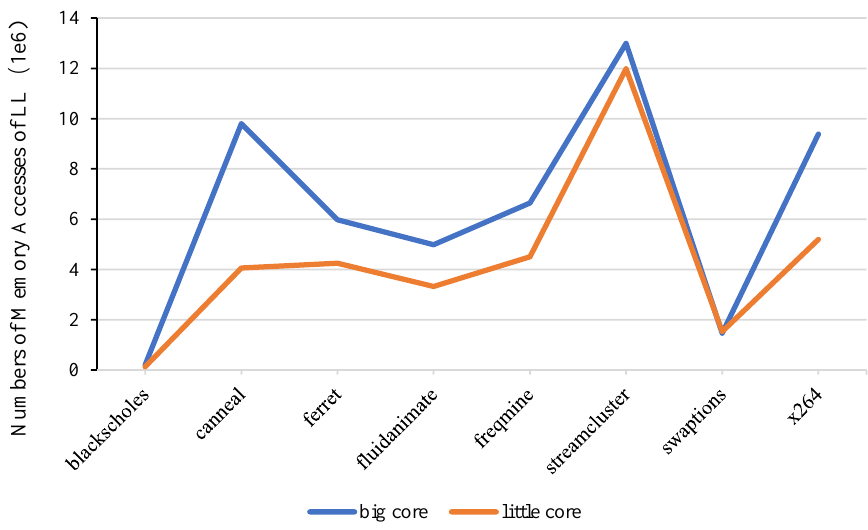
Figure 1. Difference in the number of LLC accesses between big and little